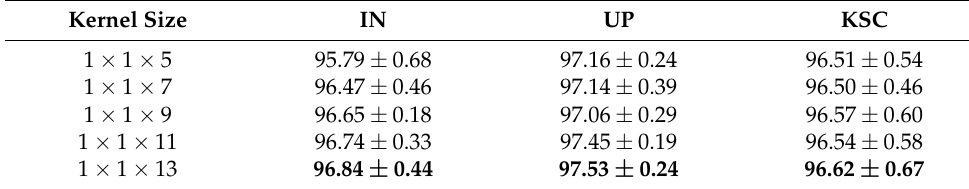
Table 3. Results for all three experimental data sets, in terms of OA(%), as a function of kernel size in 3D point-wise convolution. The best results are highlighted in bold font. Kernel Size IN UP KSC 1 × 1 × 5 95.79 ± 0.68 97.16 ± 0.24 96.51 ± 0.54 1 × 1 × 7 96.47 ± 0.46 97.14 ± 0.39 96.50 ± 0.46 1 × 1 × 9 96.65 ± 0.18 97.06 ± 0.29 96.57 ± 0.60 1 × 1 × 11 96.74 ± 0.33 97.45 ± 0.19 96.54 ± 0.58 96.84 ± 0.44 96.62 ±